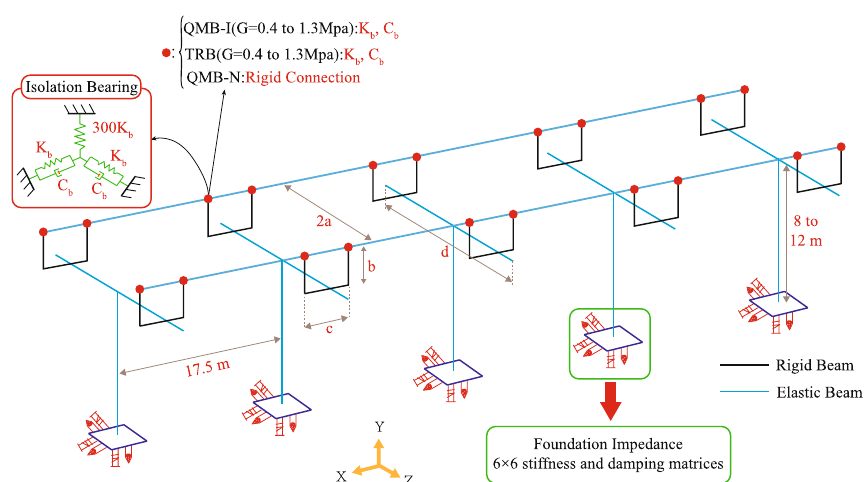
Fig. 17 3D model used for time-history analysis of Bridges based on flexibility